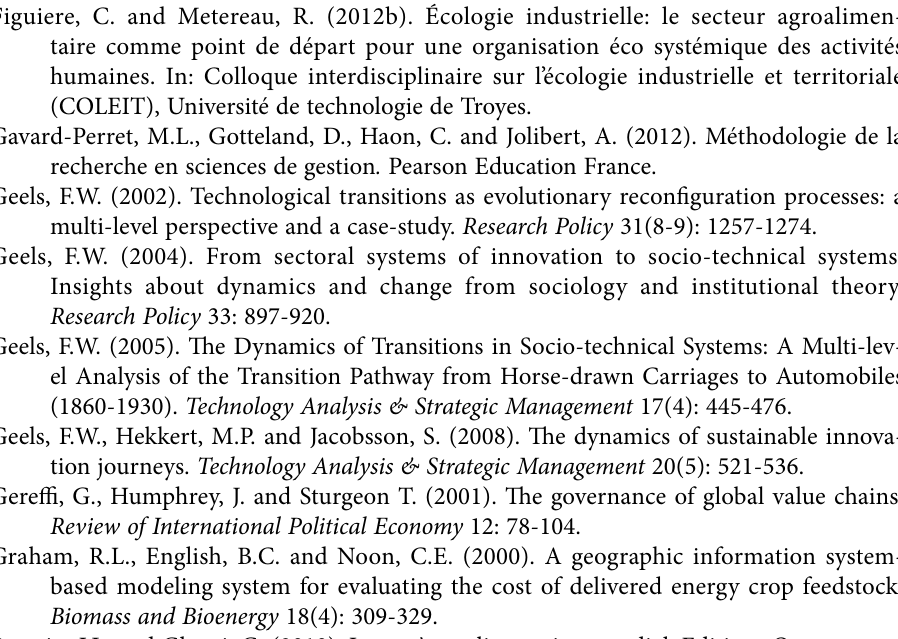
Figuiere, C. and Metereau, R. (2012b). Écologie industrielle: le secteur